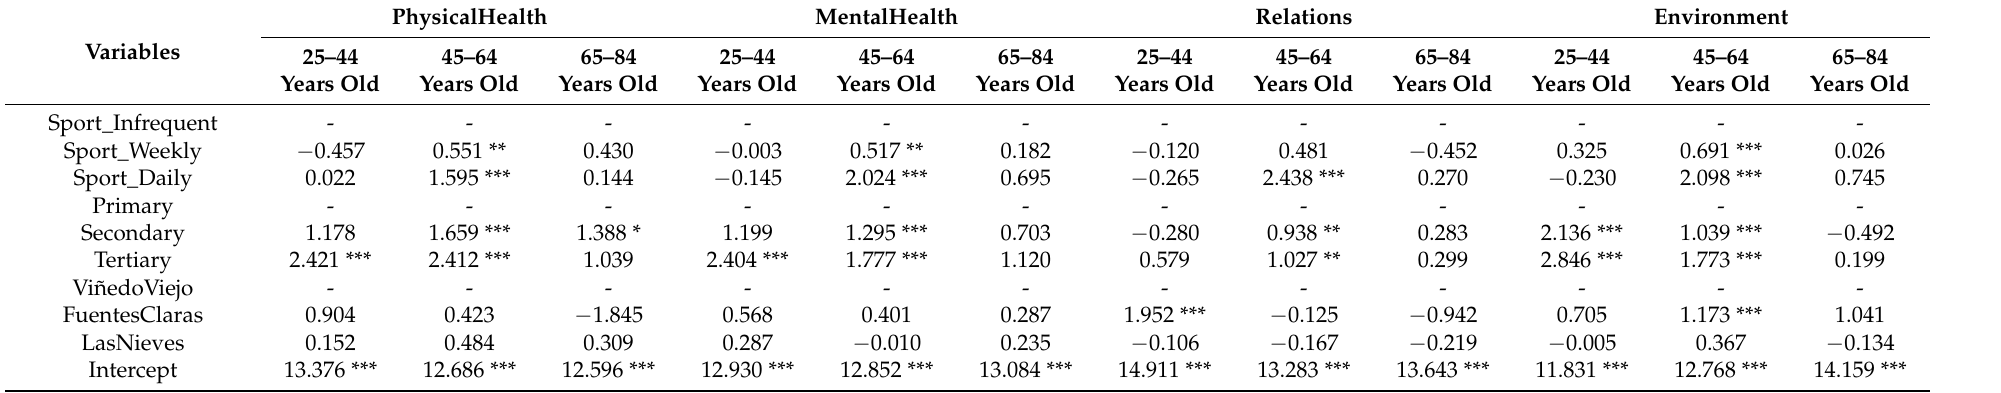
Table 6. Regression coefficients of health socio-economic determinants for women living in Casablanca ( n =